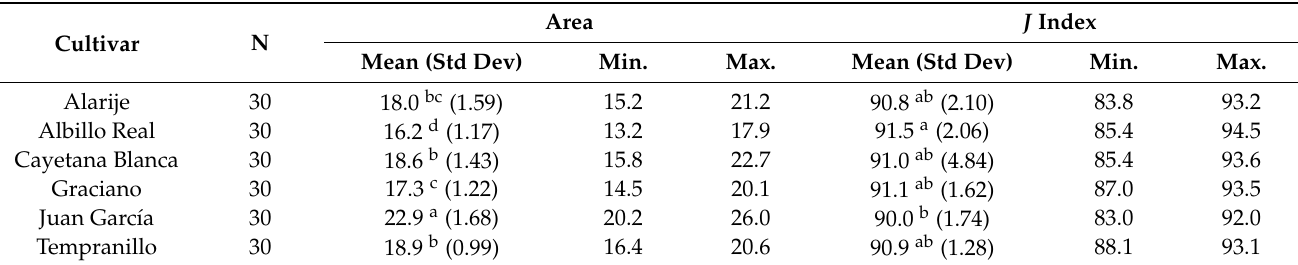
Table 5. Values of area and J index in the cultivars of the Albillo Real group. Superscript letters indicate the results of Scheff é test: the mean values marked with the same letter in the superindex of each column do not differ significantly at p < 0.05. N is the number of seeds analyzed.